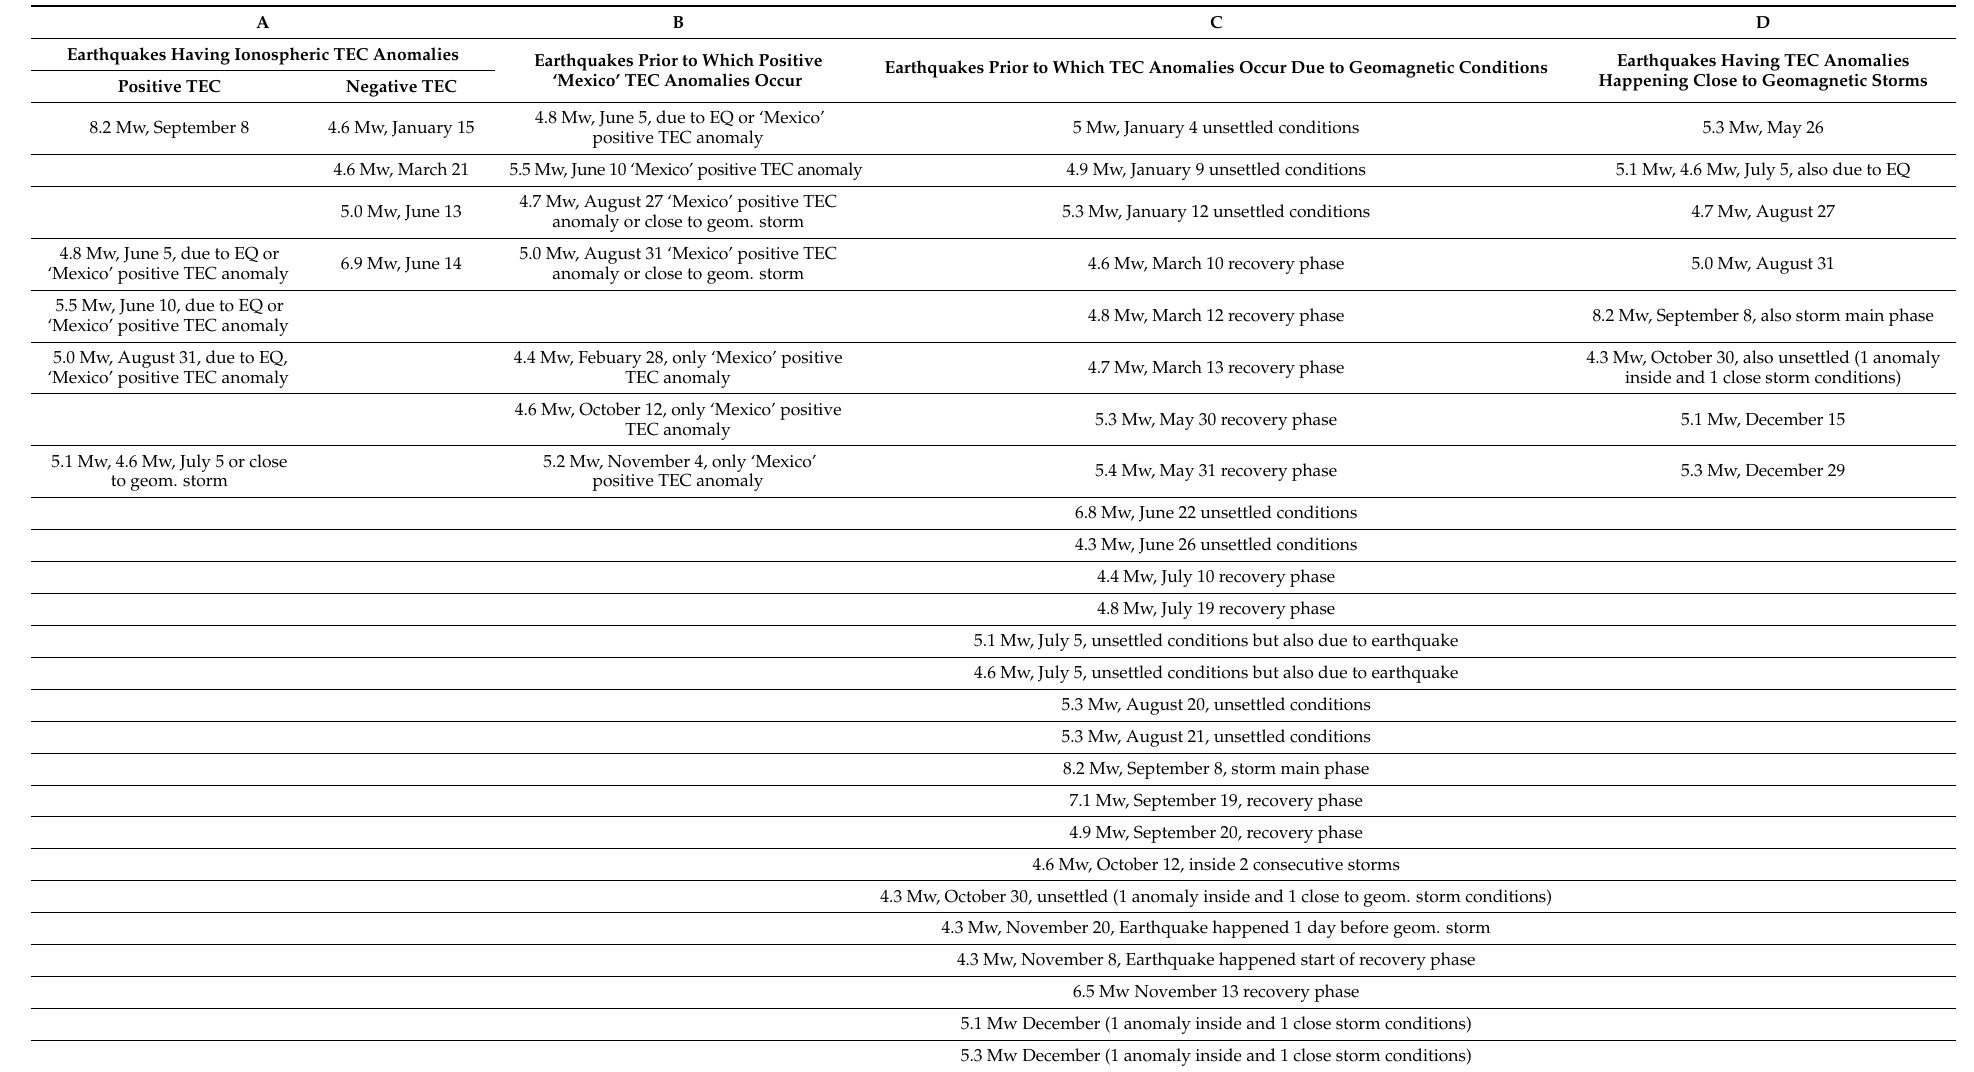
Table 2. List of earthquakes during 2017 along with the different type of observed TEC anomalies prior to their occurrence. A B C D Earthquakes Having Ionospheric TEC Anomalies Earthquakes Prior to Which Positive Earthquakes Prior to Which TEC Anomalies Occur Due to Geomagnetic ‘Mexico’ TEC Anomalies Occur